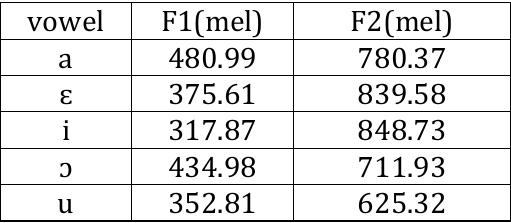
Table 3 : Mel values of all 5 vowels